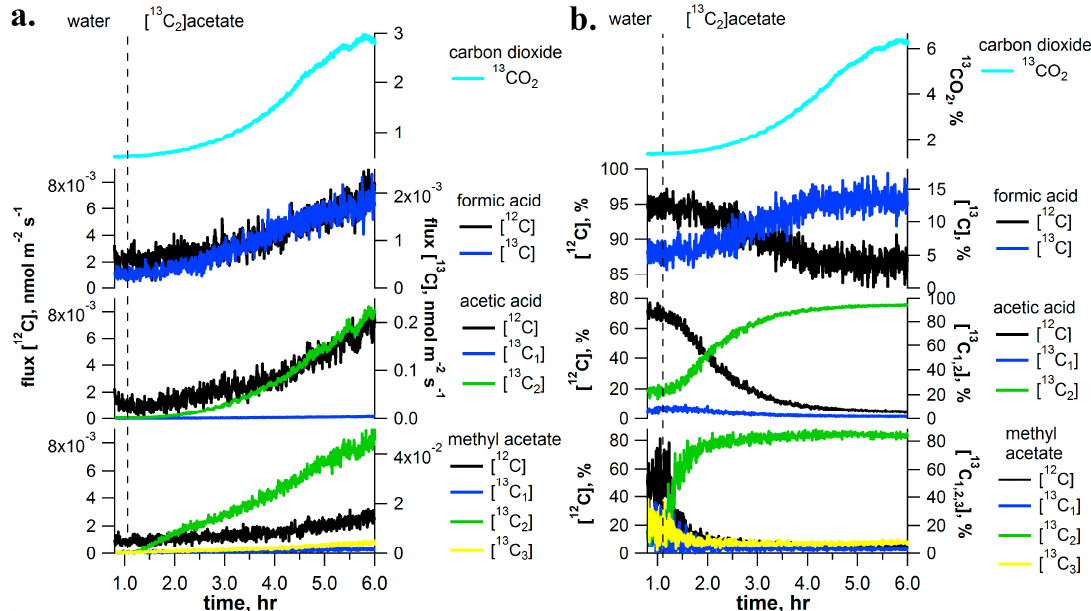
Figure 5. Example of [ 13 C 2 ]acetate labeling of a detached branch of I. edulis showing real-time [ 13 C]labeling dynamics of C 1 and C 2 volatile metabolites using PTR-MS (absolute emissions in ( a ) and relative emissions in ( b )). 13 CO 2 emission analysis of the dynamic headspace atmosphere are also shown based on CRDS. Vertical dashed line indicates a rapid change of solutions delivered to the transpiration stream (i.e., water to [ 13 C 2 ]acetate). Note: despite a strong labeling of CO 2 emissions, significant labeling of methanol and formaldehyde emissions were not observed (data not shown).